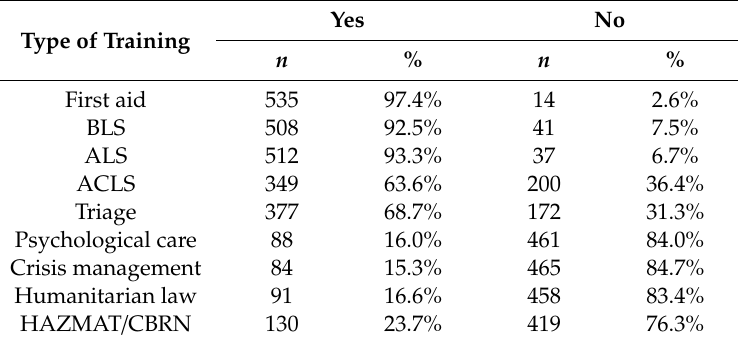
Table 4. Training courses completed.